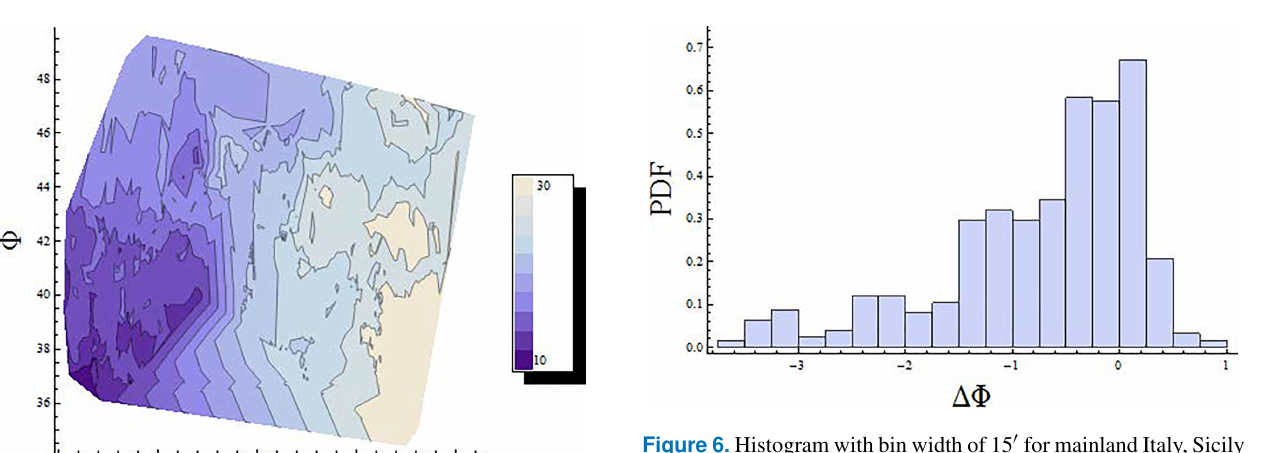
Figure 6. Histogram with bin width of 15 (cid:48) for mainland Italy, Sicily and